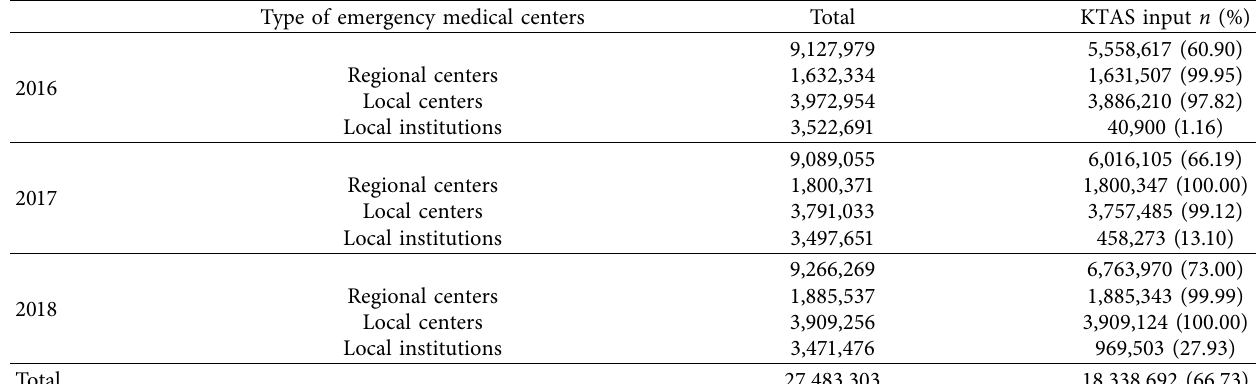
Figure 1: Flow chart describing case enrollment. Of 18,298,535 patients, 11,668,581 patients (63.77%) had appropriate usage and 6,629,954 (36.23%) had inappropriate usage. Around 2,408,845 (13.16%) belonged to the appropriate (ambulance used) group, 5,147,352 (28.13%) belonged to the underuse group, 9,259,706 (50.60%) belonged to the appropriate (no ambulance used) group, and 1,482,602 (8.10%) belonged to the overuse group. ∗ KTAS: Korean Triage and Acuity Scale. Table 1: KTAS input rate by type of emergency medical